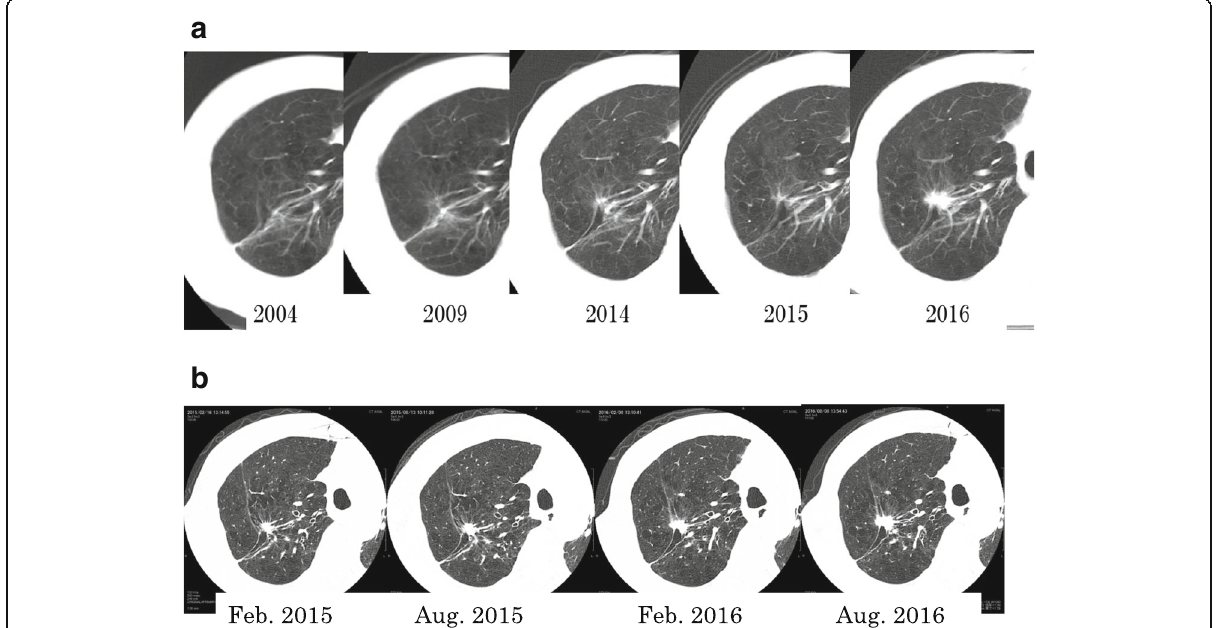
Fig. 2 a Radiographic time course on conventional computed tomography (CT) images (0.8-cm slice) for 13 years. b Radiographic time course on thin-slice CT images (0.1-cm slice) for the last 2